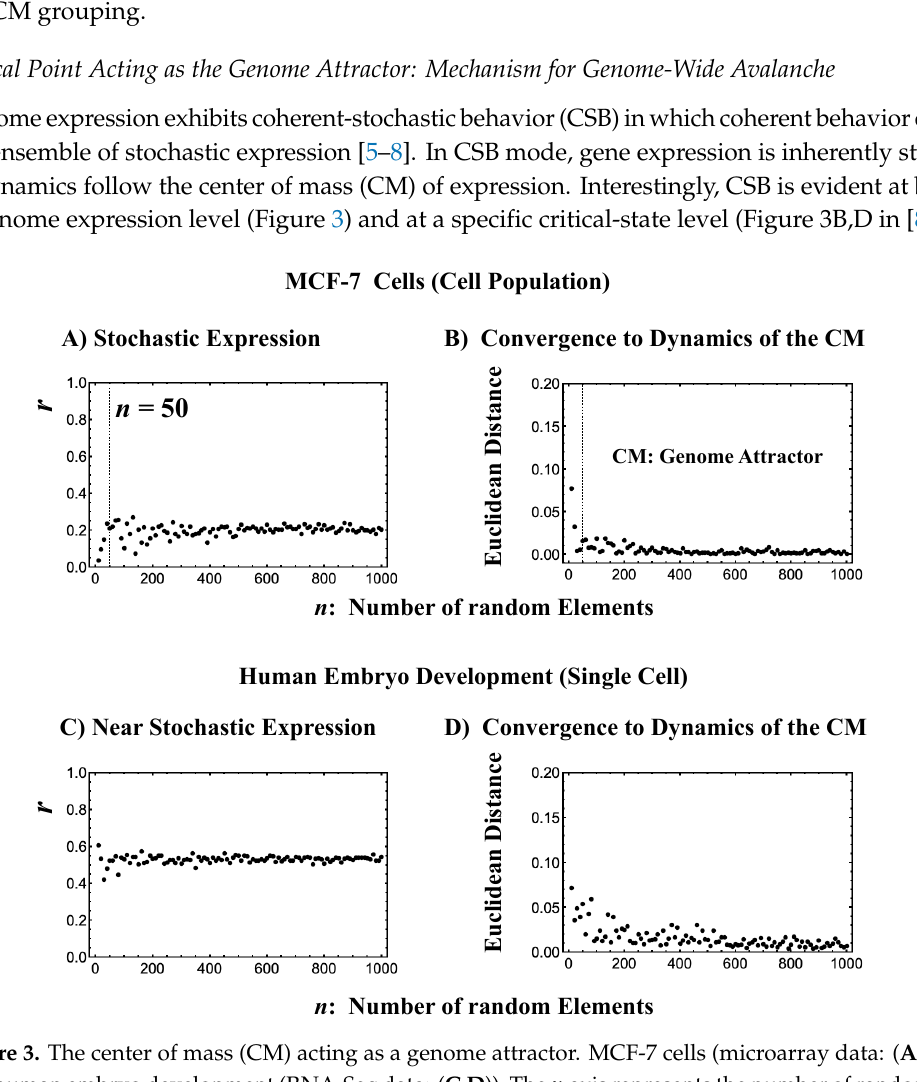
Figure 3. The center of mass (CM) acting as a genome attractor. MCF-7 cells (microarray data: ( A ) and ( B )) and human embryo development (RNA-Seq data: ( C ) and ( D )). The x -axis represents the number of randomly selected single-gene expression values in all four panels. Panels ( A ) and ( C ) illustrate that bootstrapping highlights a low pairwise Pearson correlation ( y -axis) in randomly selected groups of expression (computed over experimental time points with 200 repetitions). This confirms the stochastic character of gene expression. Note: In ( C ), the removal of all genes with zero expression value at a specific cell state in RNA-Seq data does not change their correlation behavior (similar behavior is also observed in the mouse embryo case). Furthermore, the higher correlation in the embryo case makes the convergence to the CM, shown in ( D ), slower than in the cancer case ( B ). Panels ( B ) and ( D ) illustrate, in terms of Euclidean distance ( y -axis; refer to the convergency of critical- state attractors: Section 2.6), the convergence of the dynamics of the CM of a randomly selected group of gene expression to that of the CM of whole-genome expression as the number of selected genes increases (average of 200 repetitions). The CP, the CM of whole-genome expression according to nrmsf , acts as the genome attractor (see Section 2.6 for heteroclinic attractors). Note: For the rest of the biological regulations throughout this report, similar behaviors are observed. The dashed lines in ( A ) and ( B ) indicate that coherent behaviors emerge at n = 50 single-gene expression values. Refer to experimental time points in Section 4.1. 2.3. ON/OFF State of the CP: Cell Fate-Guiding and Global Avalanches 2.3.1. MCF-7 Breast Cancer Development (Cell-Population Level): ON–OFF State of the CP Revealed We consider the cell-fate change equivalent to a genome-state change (refer to biological discussions in [7]). The genome-state change occurs in such a way that the initial-state SOC control of whole-genome expression, which is in charge of maintaining a largely invariant global gene-